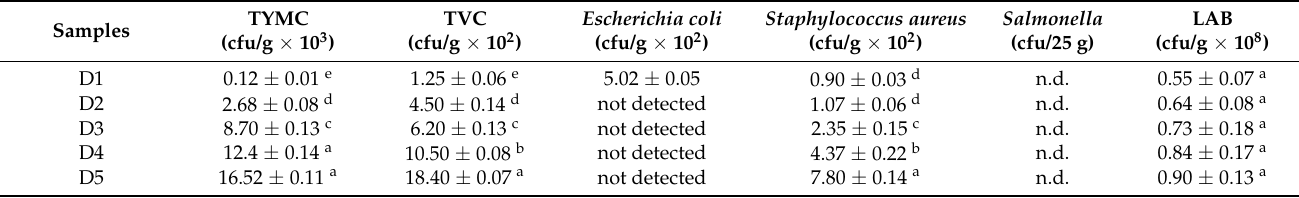
Table 3. Microbiological parameters of cheese samples during